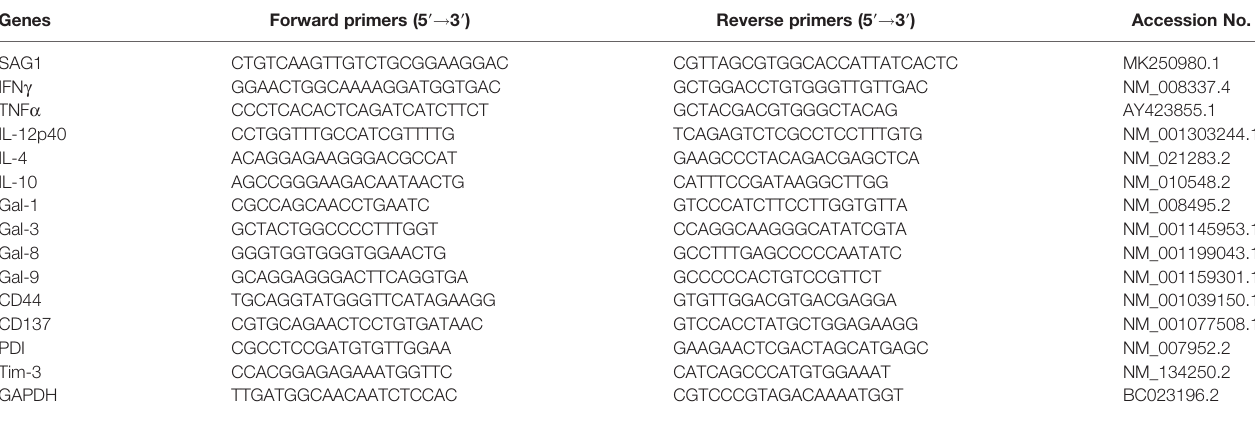
TABLE 1 | Primer sequences of genes used for quantitative real-time polymerase chain reaction assays. Genes Forward primers (5 ′ ! 3 ′